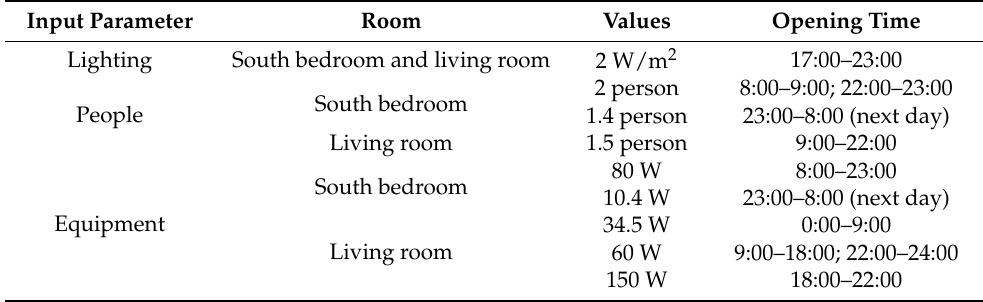
Table 8. Internal gains for the